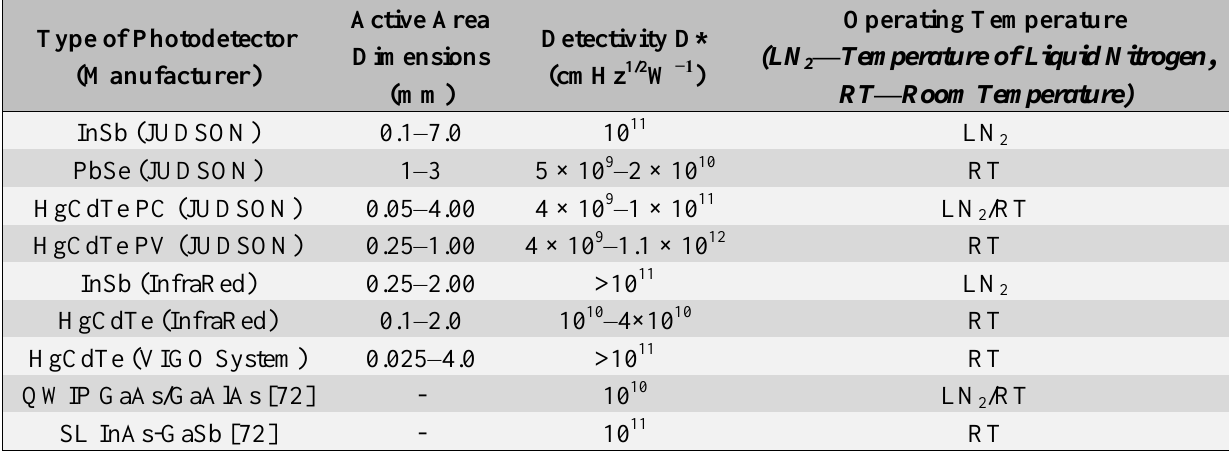
Table 3. Example parameters of selected detectors.